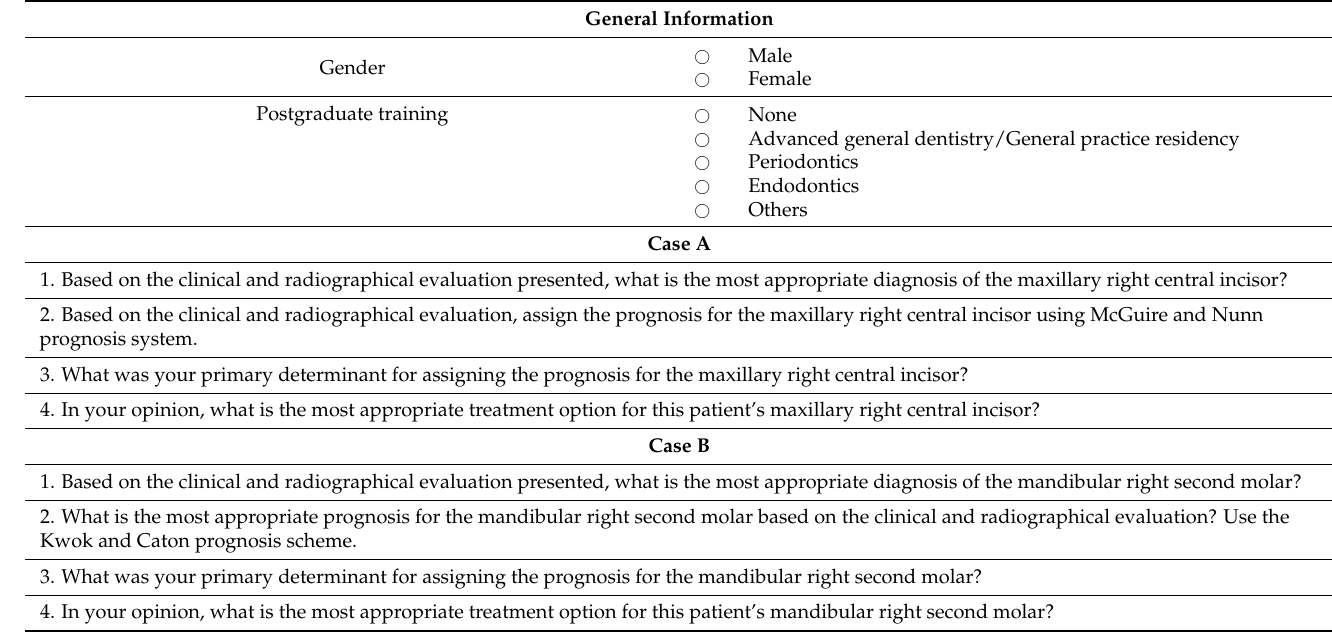
Table 1. Questionnaire used in this